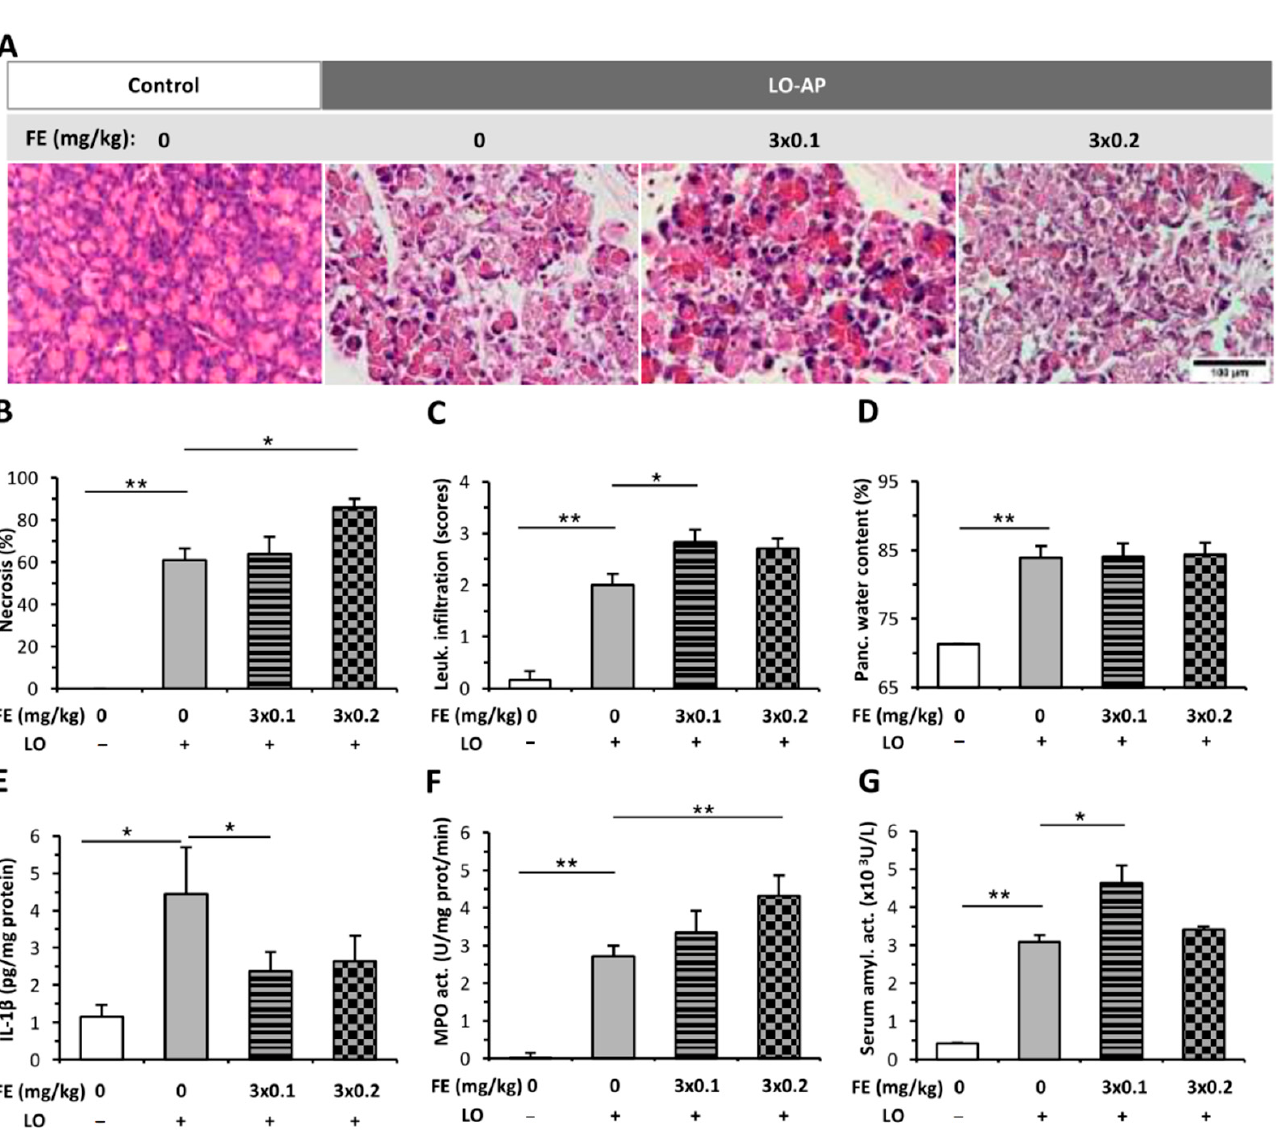
Figure 1. Fentanyl (FE) pre-treatment in L-ornithine (LO)-induced necrotizing acute pancreatitis (AP). Rats were treated with 3 × 0.1 or 3 × 0.2 mg/kg FE intraperitoneally (i.p.), whereas i.p. injection with 3 g/kg LO-HCl (LO +) was used to induce AP. Control animals received physiological saline instead of LO (LO − ) or FE (0 mg/kg). Animals were sacrificed at 24 h after LO or physiological saline injection. ( A ) Representative histopathological images of pancreatic tissues of the treatment groups. Bar charts show the extent of pancreatic ( B ) necrosis, ( C ) leukocyte infiltration, ( D ) water content, ( E ) interleukin-1 β (IL-1 β ) concentration, ( F ) myeloperoxidase (MPO) activity, and ( G ) serum amylase activity measurements. Values represent means with standard error, n = 9–11. Two-way ANOVA was performed followed by the Holm–Sidak post hoc test. * p < 0.05; ** p < 0.001.